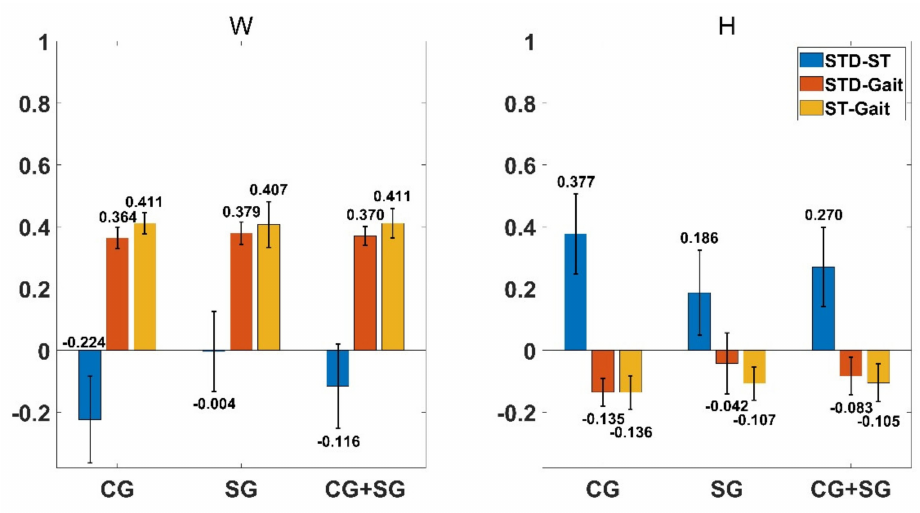
Figure 7. Inter-similarity between any two of the three motions (STD, ST and Gait) performed of different subject groups (CG, SG and the combined group CG + SG). The numbers on the bar represent the corresponding average similarity